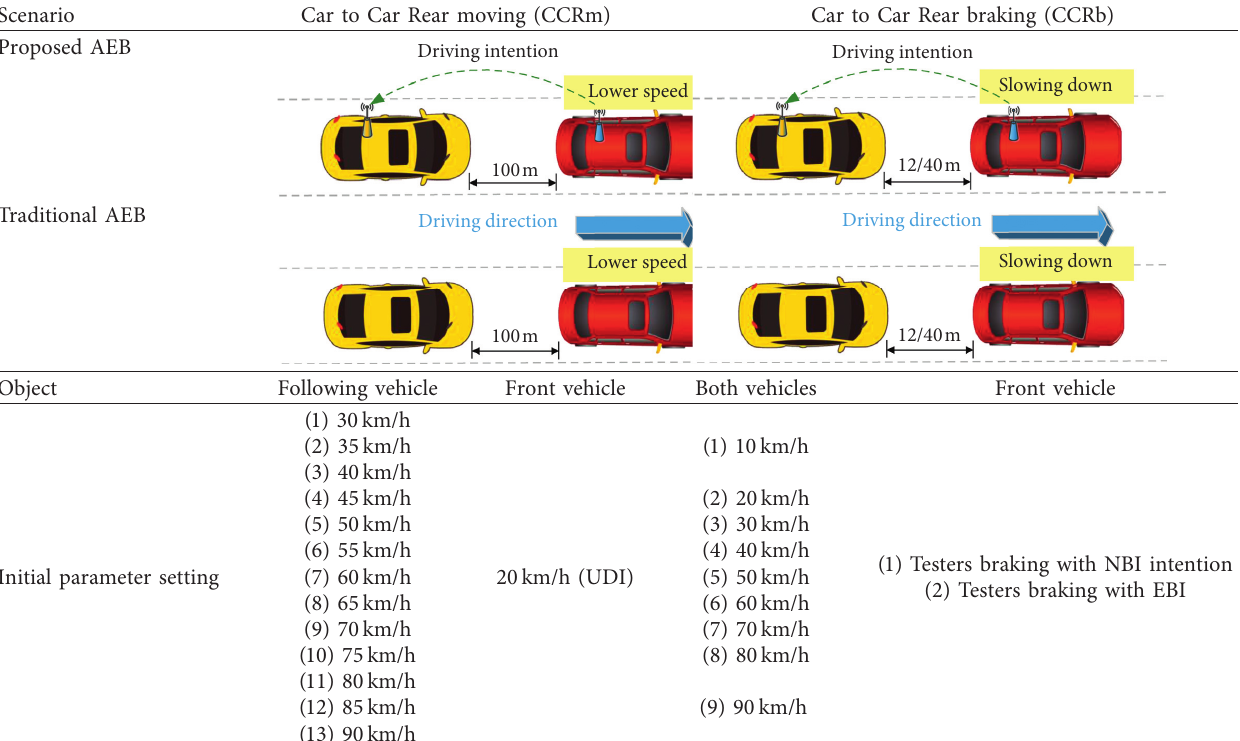
Table 2: AEB model comparison test conditions.